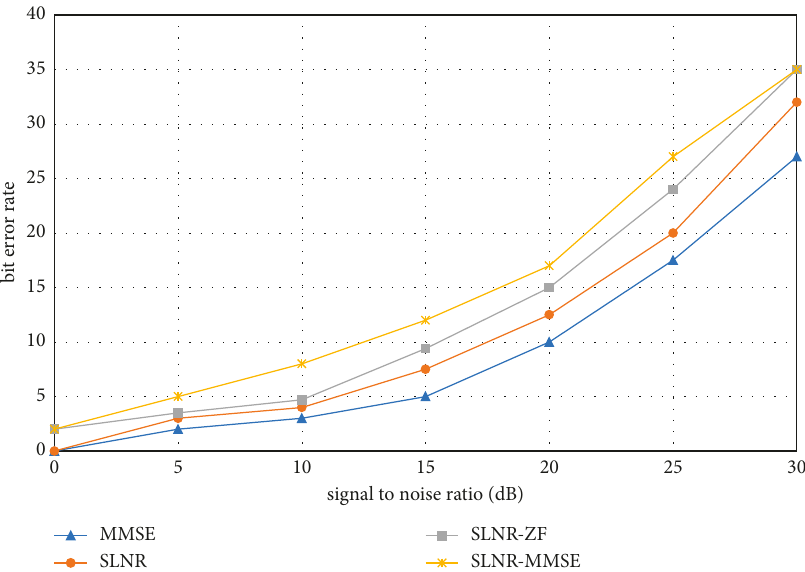
Figure 7: Bit error rate before and after the improvement of SLNR precoding algorithm when the antenna configuration is 3